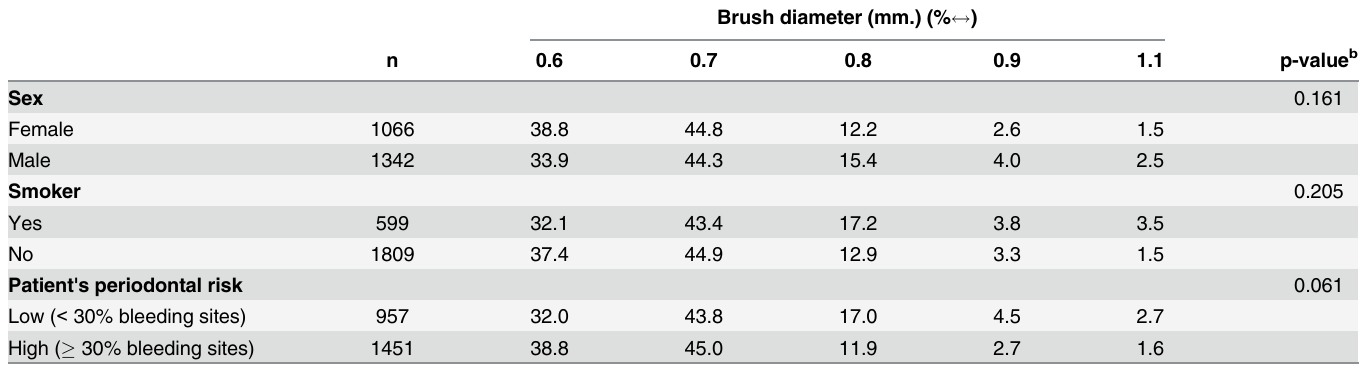
Table 4. Distribution of interproximal sites (n = 2408a) from 99 adults according to adult ’ s